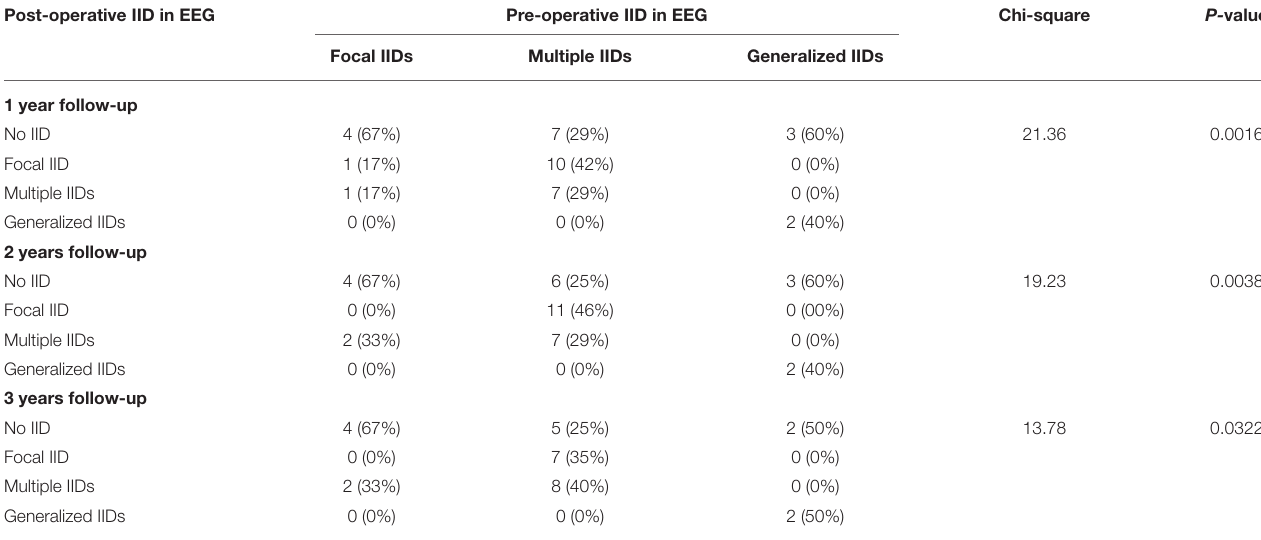
TABLE 1 | Relationships between IIDs patterns on pre- and post-operative EEGs. Post-operative IID in